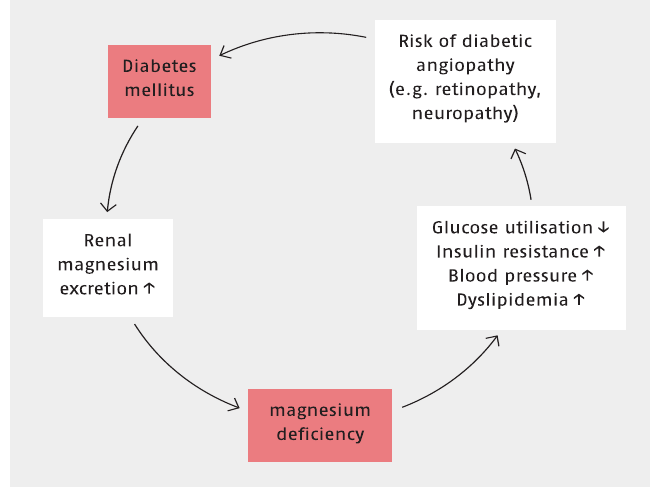
Figure 2. Magnesium deficiency and diabetes [63,71].